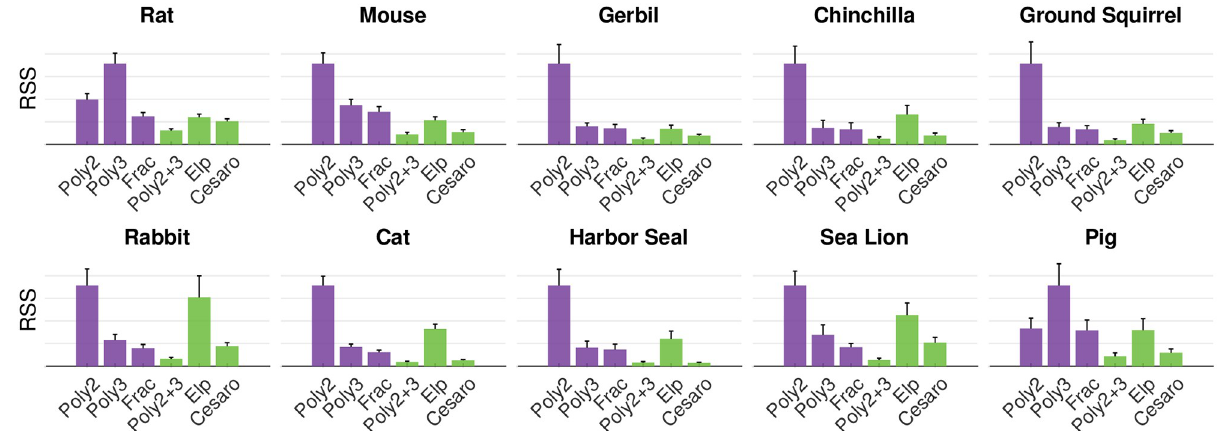
Fig 8. RSS is compared for all models for all species. In each subplot, the y-axis is normalized to the maximum value. All plots show adjusted RSS to account for differences in the number of parameters (either one or two). Poly2: y = a 2 x 2 . Poly3: y = a 3 x 3 . Poly2+3: y = a 3 x 3 +a 2 x 2 . Frac: Fractional exponent model. Elp: Elliptical